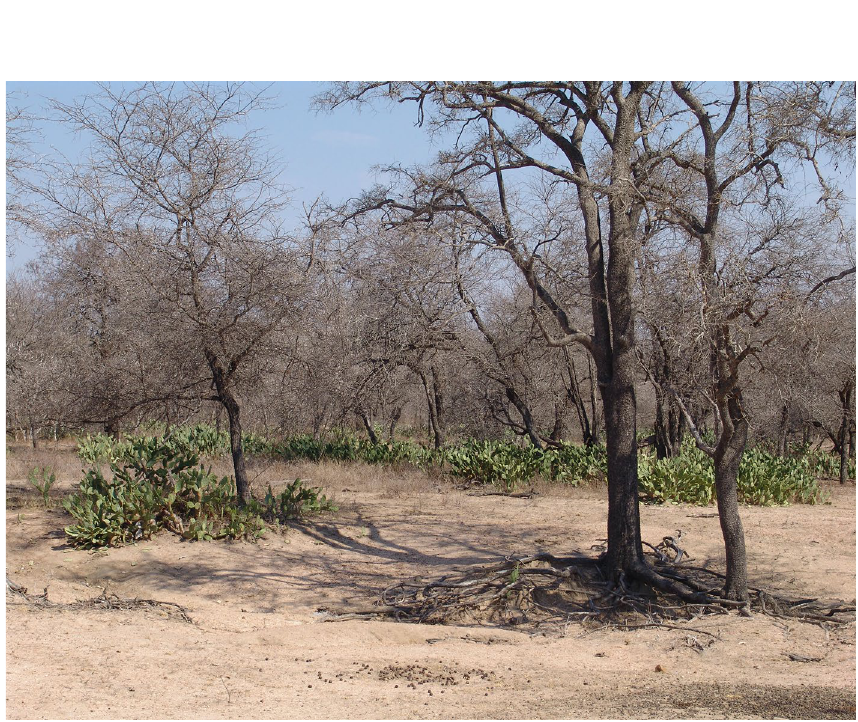
Figure 6. Opuntia stricta growing under de canopy of Vachellia nilotica (background), while no O. stricta plants are visible under the canopy of Spirostachys africana (front right) or in open patches with no tree